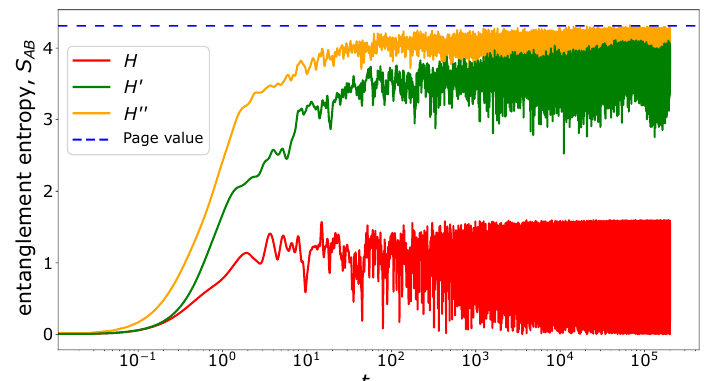
Figure 19: Growth of entanglement entropy S for an initial random state in S z - AB basis in the M = 6, M x = M y = ( 1,1,...,1 ) symmetry sector of the 6 × 6 lattice with o.b.c., for different interaction ranges. S saturates to different values below AB ≈ 4.29, at a rate that increases upon the Page value for this symmetry sector, S AB ,Page the increase of the interaction range. The system under ˆ H explores a 13-dimensional fragment of the Hilbert space and exhibits periodic behavior with perfect revivals (the first one is at t ≈ 3553), while under ˆ H ′ and ˆ H ′′ it explores the whole 720- dimensional symmetry sector. Despite the fact that the explored Hilbert space for ˆ H ′ and ˆ H ′′ is the same, the saturation value of S is larger for ˆ H ′′ , presumably since AB the connectivity of the Hilbert space is enhanced (while it is not clear if the green line ever saturates to the same value as the yellow one, we confirm numerically that it does not do so at least until t = 2.0 · 10 5